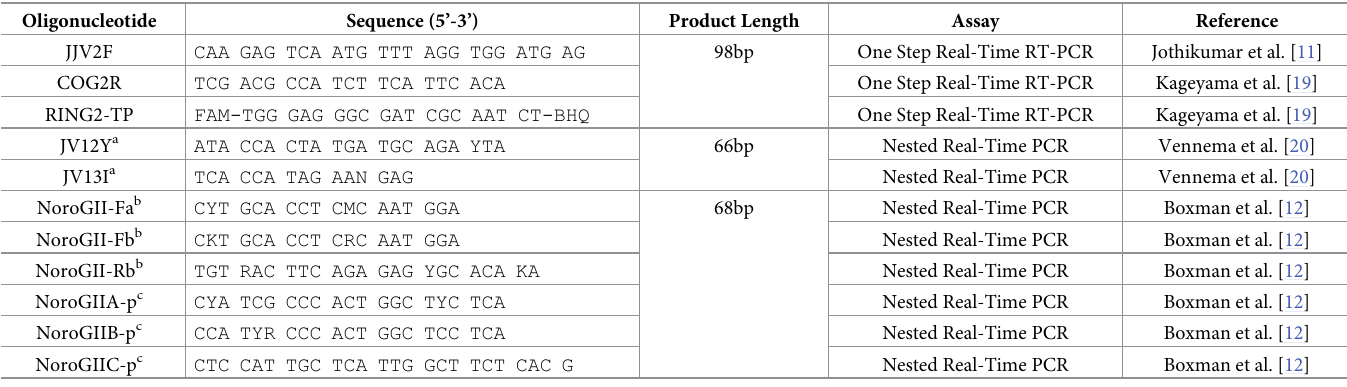
Table 1. Oligonucleotide primers and probes used in this work.